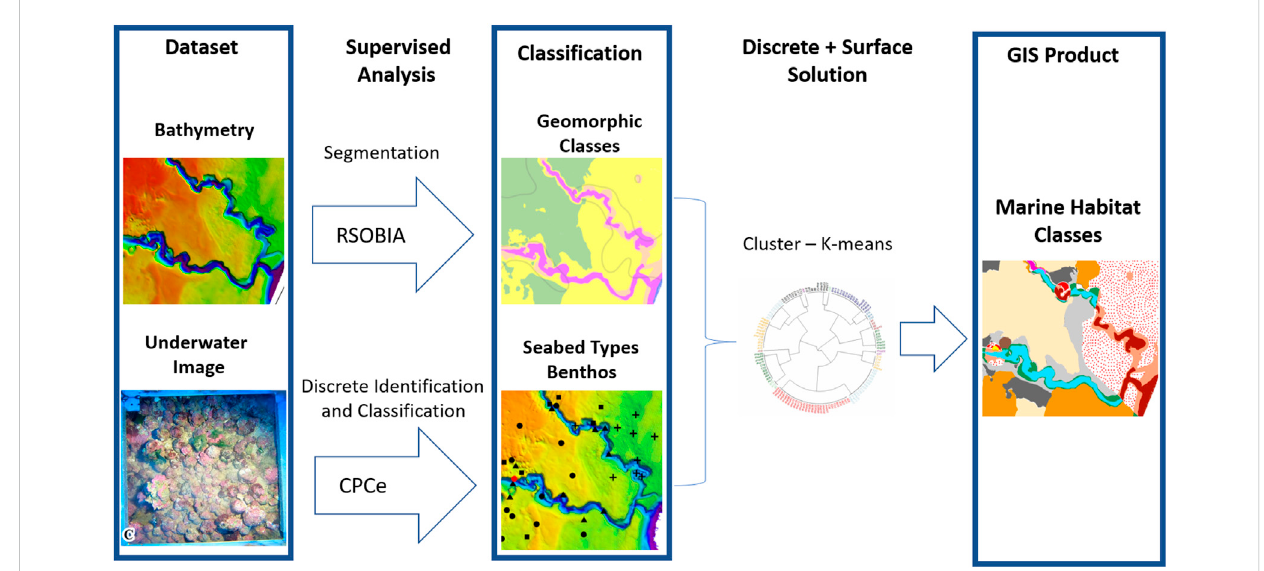
FIGURE 2 Flow chart showing the different methodological steps applied in the investigation.